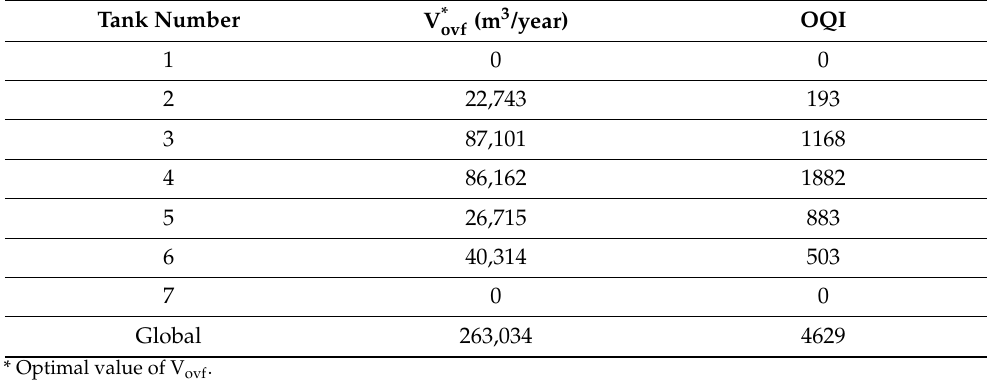
Table 13. Simulation results when the volume of overflow is minimized (strategy #4).